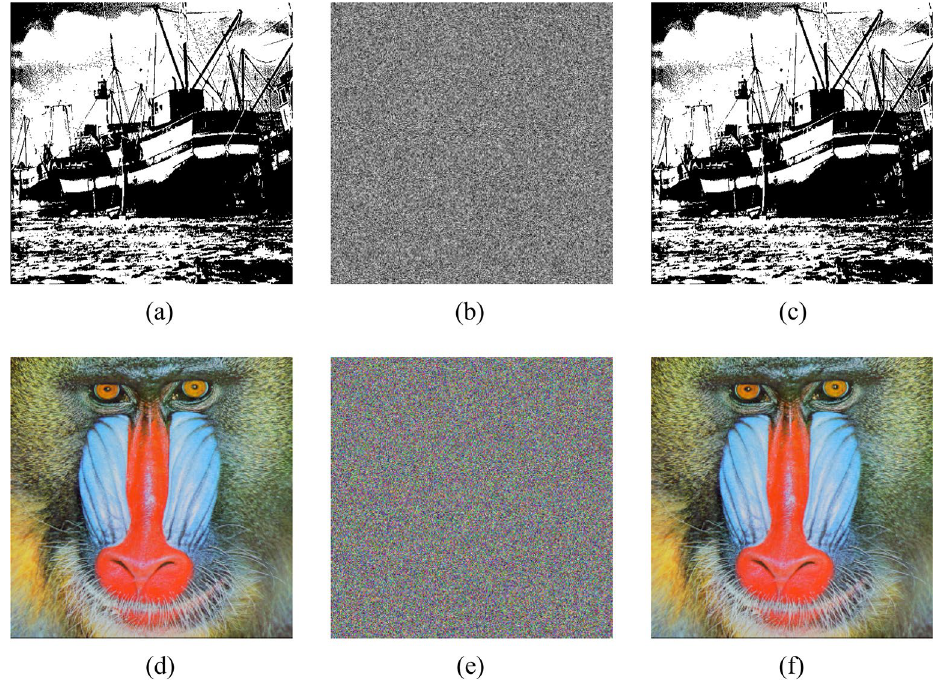
Figure 11. Encryption and decryption of binary image and color image. ( a ) Original image of Binary_boat.512, ( b ) encrypted image of Binary_boat.512, ( c ) decrypted image of Binary_boat.512. ( d ) original image of image 4.2.03, ( e ) encrypted image of image 4.2.03, ( f ) decrypted image of image